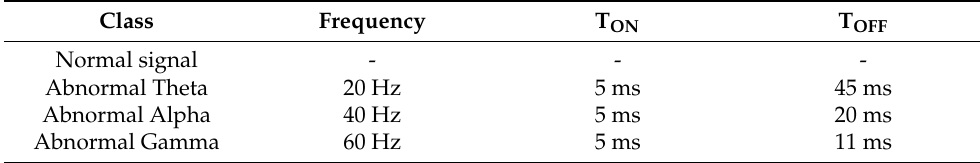
Table 1. Stimulation parameters for different signal classifications.